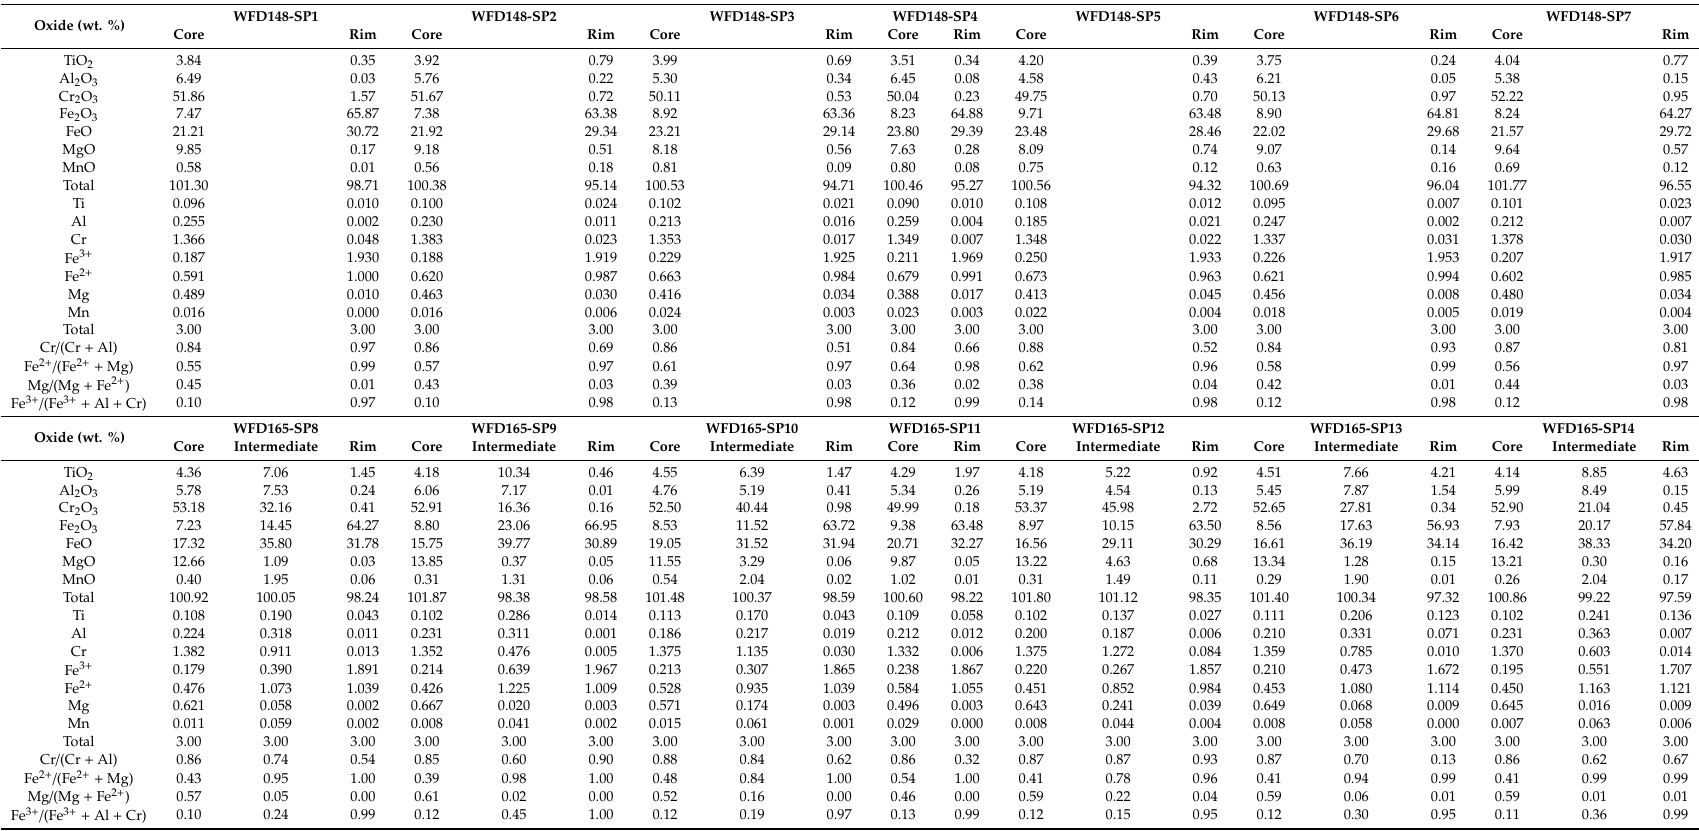
Table 1. Mineral chemistry (oxide wt. %) of magmatic spinels from the No.30 kimberlite. Oxide(wt.